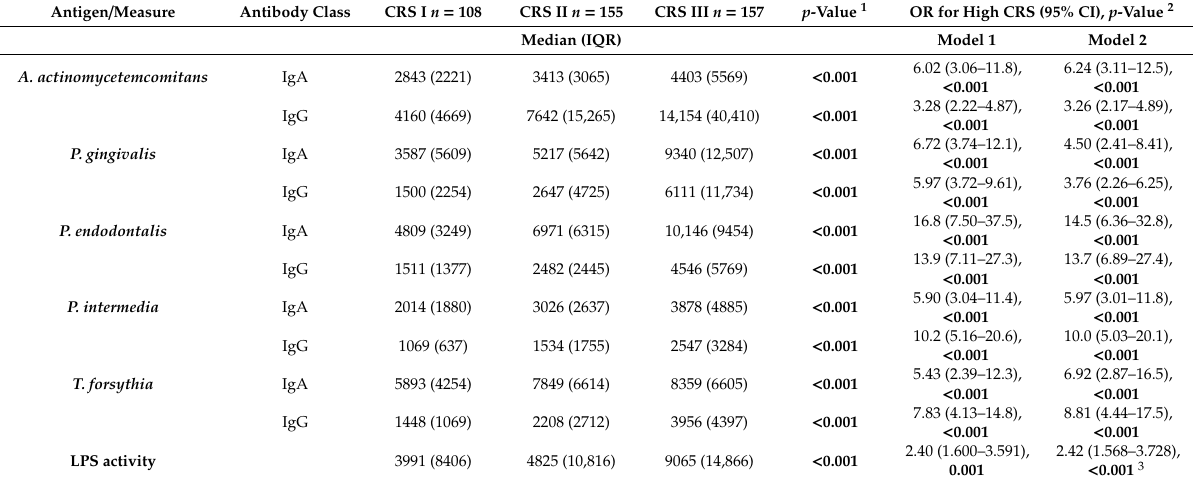
Table 3. Saliva antibody levels in response to five periodontal pathogens and lipopolysaccharide (LPS) levels according to the